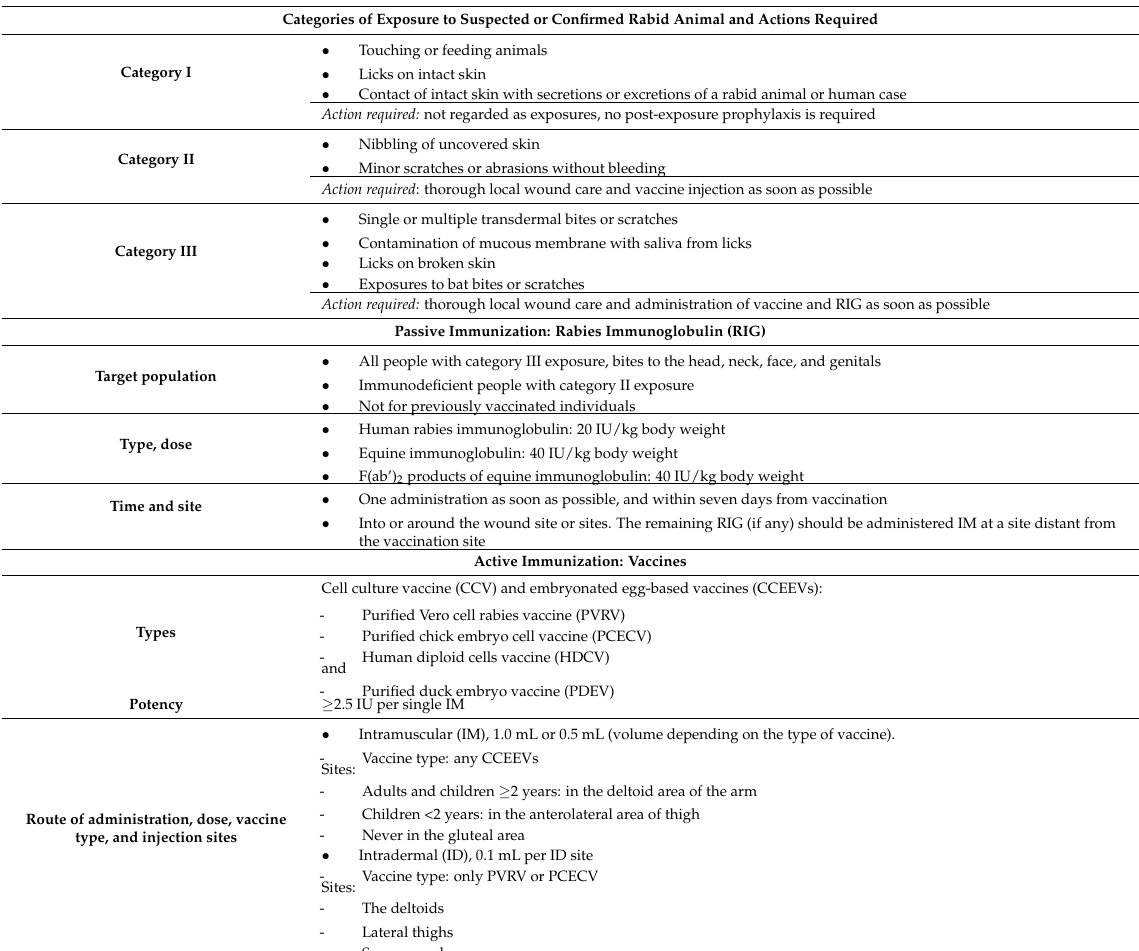
Table 1. World Health Organization (WHO) recommendations for human rabies